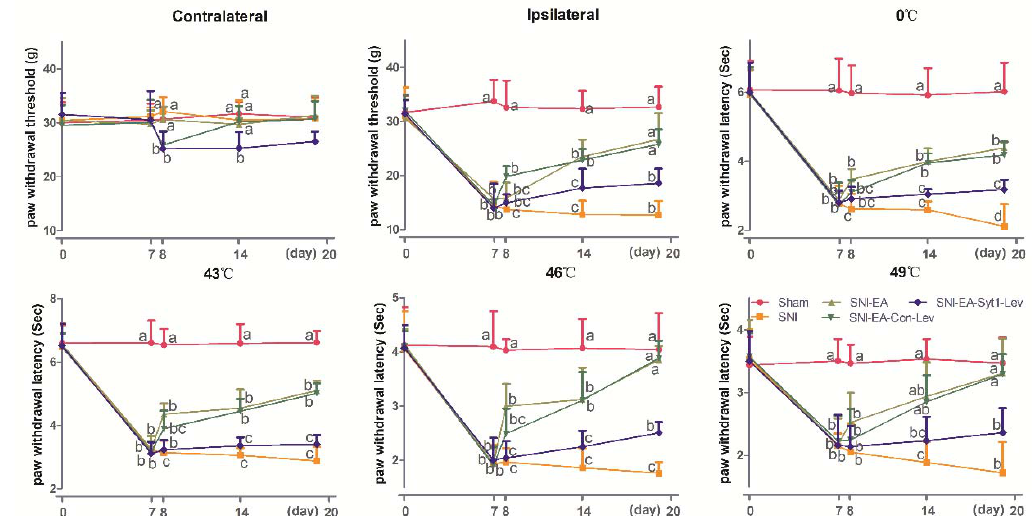
Figure 6. The e ff ect of EA on PWTs and PWLs (Mean ± SD, n = 6). Rats in SNI-EA, SNI-EA-Con-Lev, or SNI-EA-Syt1-Lev groups were treated with EA at day 8, 10, 12, 14, 16, 18, and 20, for 7 times in total. Rats in the SNI-EA-Syt1-Lev or SNI-EA-Con-Lev groups were intrathecally injected with 15 µ L of Syt-1 lentiviral activation particles or lentiviral control particles. The SNI-EA group showed increased ipsilateral PWTs, PWLs (0, 43, and 46 ◦ C) at day 8 to 20 and PWL (49 ◦ C) at day 20 compared with the SNI group. EA induced an increase in ipsilateral PWTs and PWLs at (0, 43, and 46 ◦ C) at day 14 and 20 and in PWL (49 ◦ C) at day 20, which was reversed by the intrathecal administration of Syt-1 lentiviral activation particles. Values with di ff erent letters (a, b, and c) on the same day show di ff erent ( p < 0.05); two-way ANOVA followed by a Bonferroni test.